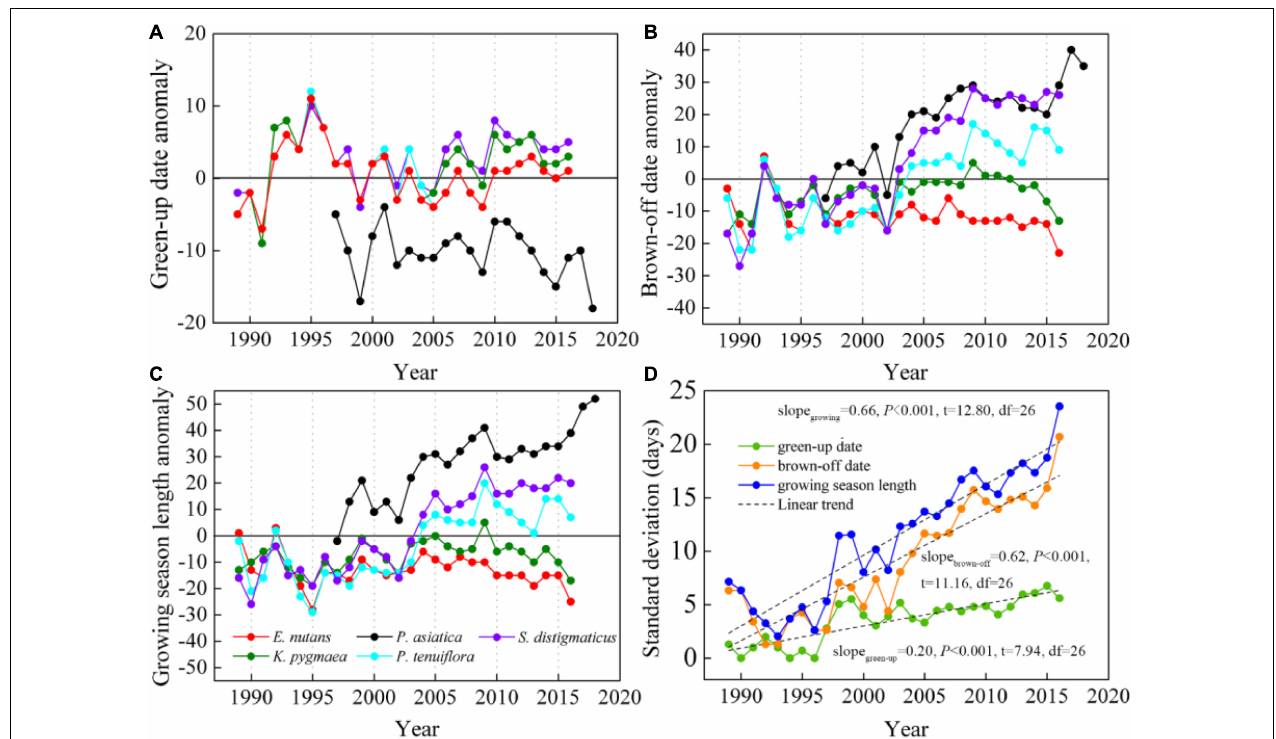
FIGURE 3 | Anomaly of herb green-up date (A) , brown-off date (B) , growing season length (C), and the interspecies standard deviations (D) in Henan Station from 1989 to 2018. Five different color legends represent different herbs, respectively. Slope green − up , slope brown − off , and slope growing in (D) represent the linear trend slopes of standard deviations of the five herbs ( Elymus nutans , Kobresia pygmaea , Plantago asiatica , Puccinellia tenuiflora , and Scirpus distigmaticus ) green-up dates, brown-off dates, and growing season lengths,